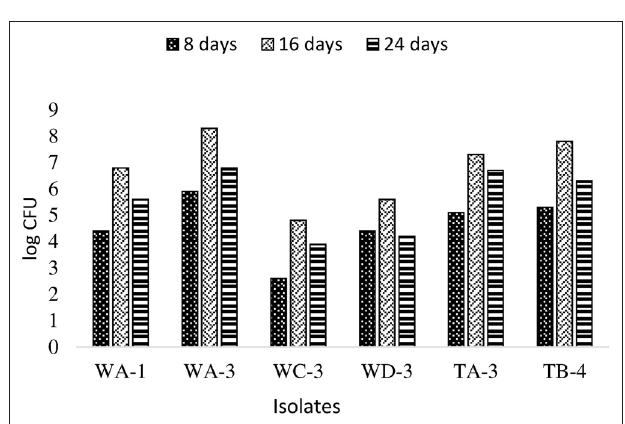
FIGURE 4 | Population density of different actinobacterial isolates inoculated to wheat at different time intervals under axenic conditions.